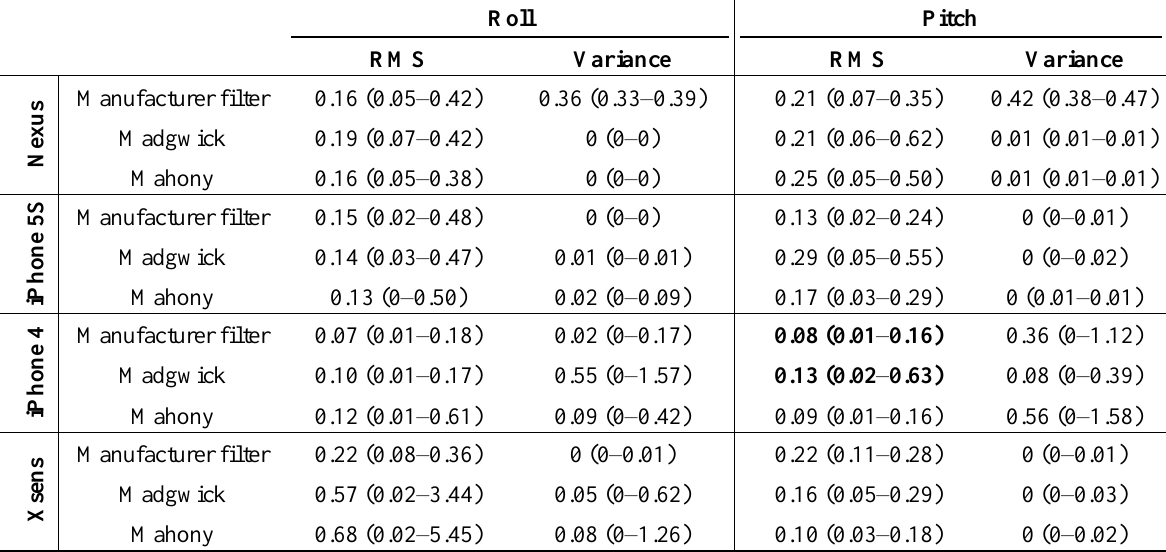
Table 3. Static protocol results, mean (min–max), for roll and pitch in degrees. Bold typesetting indicates a statistically significant difference between filters for a given manufacturer ( p < 0.01).